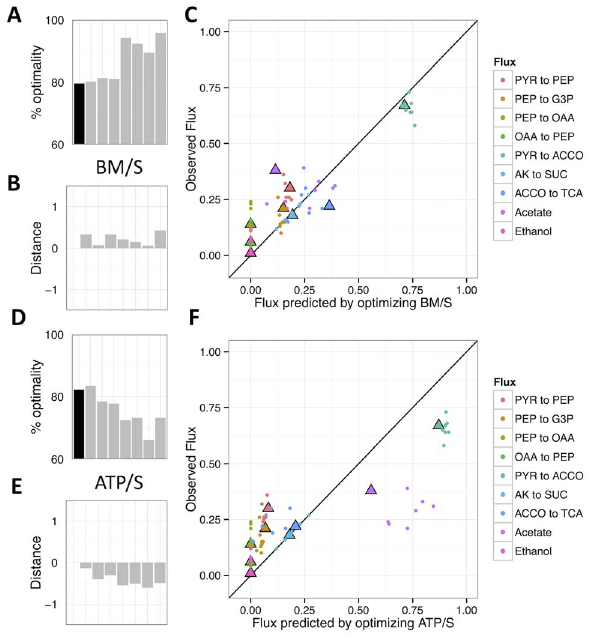
Figure 4. Measures of optimality and predictability after adaptation to lactate for , 900 generations. A,D) The % optimality of the ancestor (black) and evolved isolates (grey); B,E) distance to optimal flux distribution (plotted as log(D EO /D AO )); and C, F) comparison of predicted to observed flux ratios for FBA-predictions based upon BM/ S (A–C) or ATP/S (D–F).